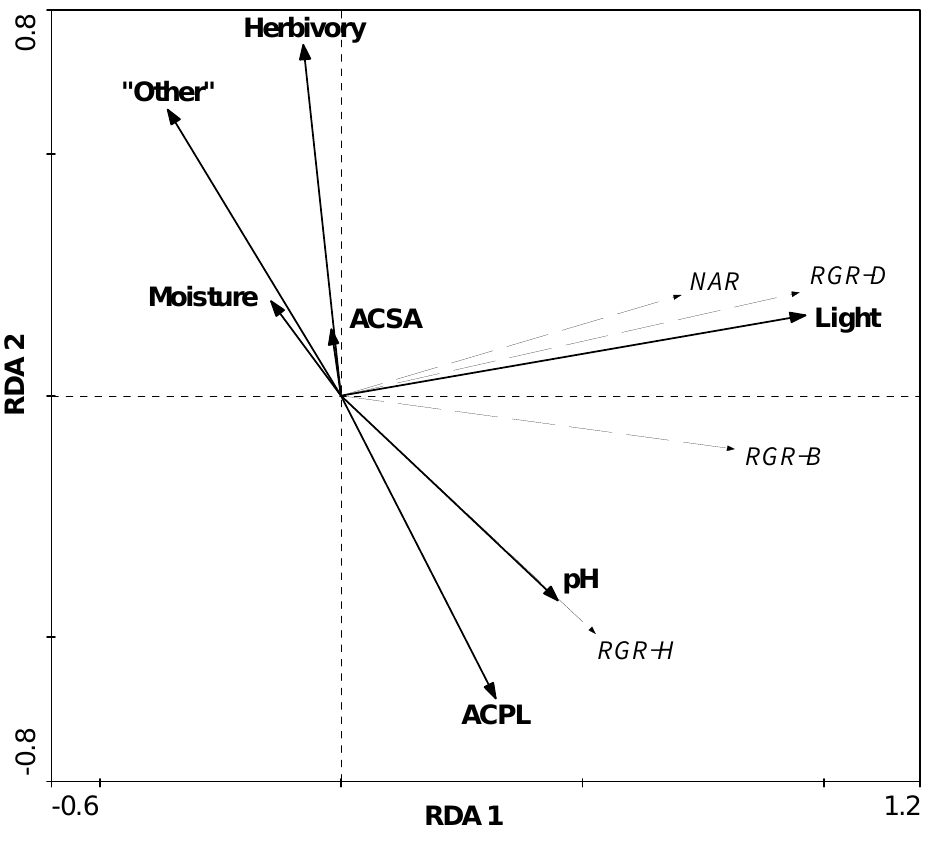
Figure 1. Redundancy-based analysis (RDA) correlation biplot representing growth parameters (dashed vectors) and ecological factors (solid vectors) of A. platanoides seedlings ( n = 55). The first and second canonical axes explain respectively 19.6% and 2.9% of variation in the data. ACPL: A. platanoides canopy; ACSA: A. saccharum canopy; “Other”: other native canopy